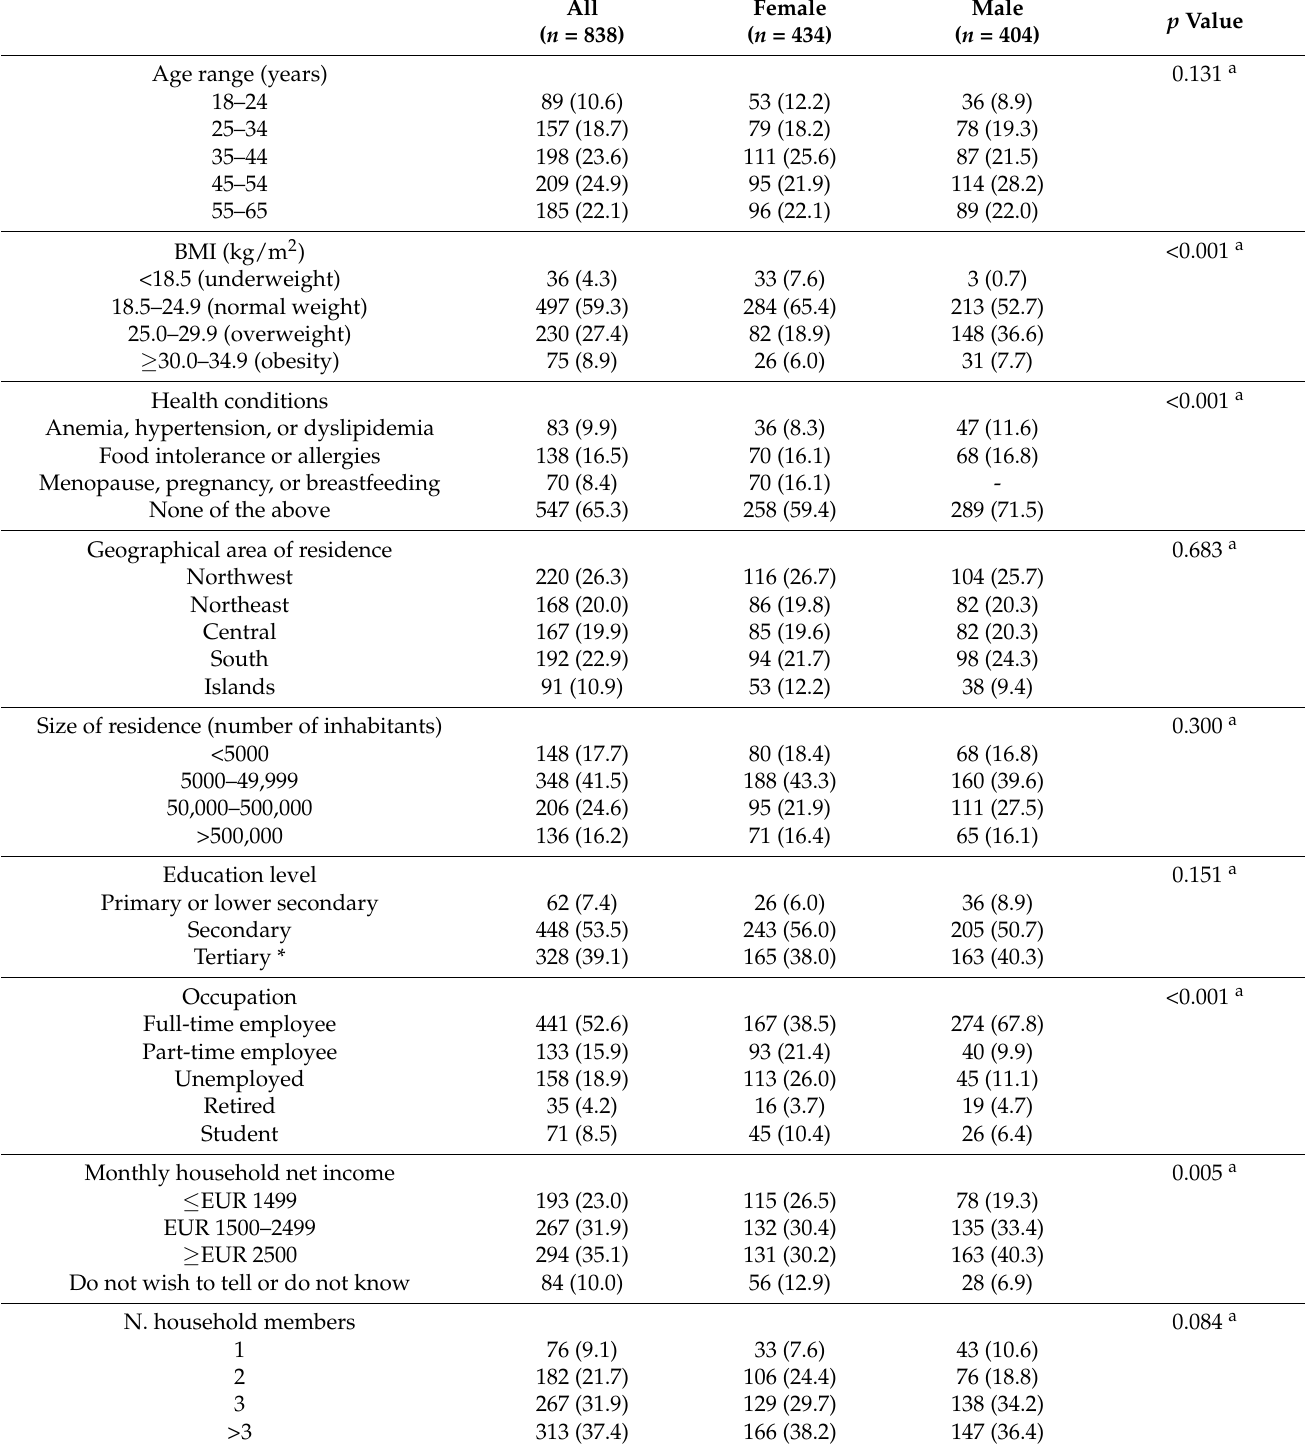
Table 1. Anthropometric variables, demographic and socioeconomic characteristics, health conditions, food-related habits, adherence to the MD, consideration of the MD as a sustainable dietary model, and self-perceived adoption of a sustainable diet in the last 3 months in the total sample, split by